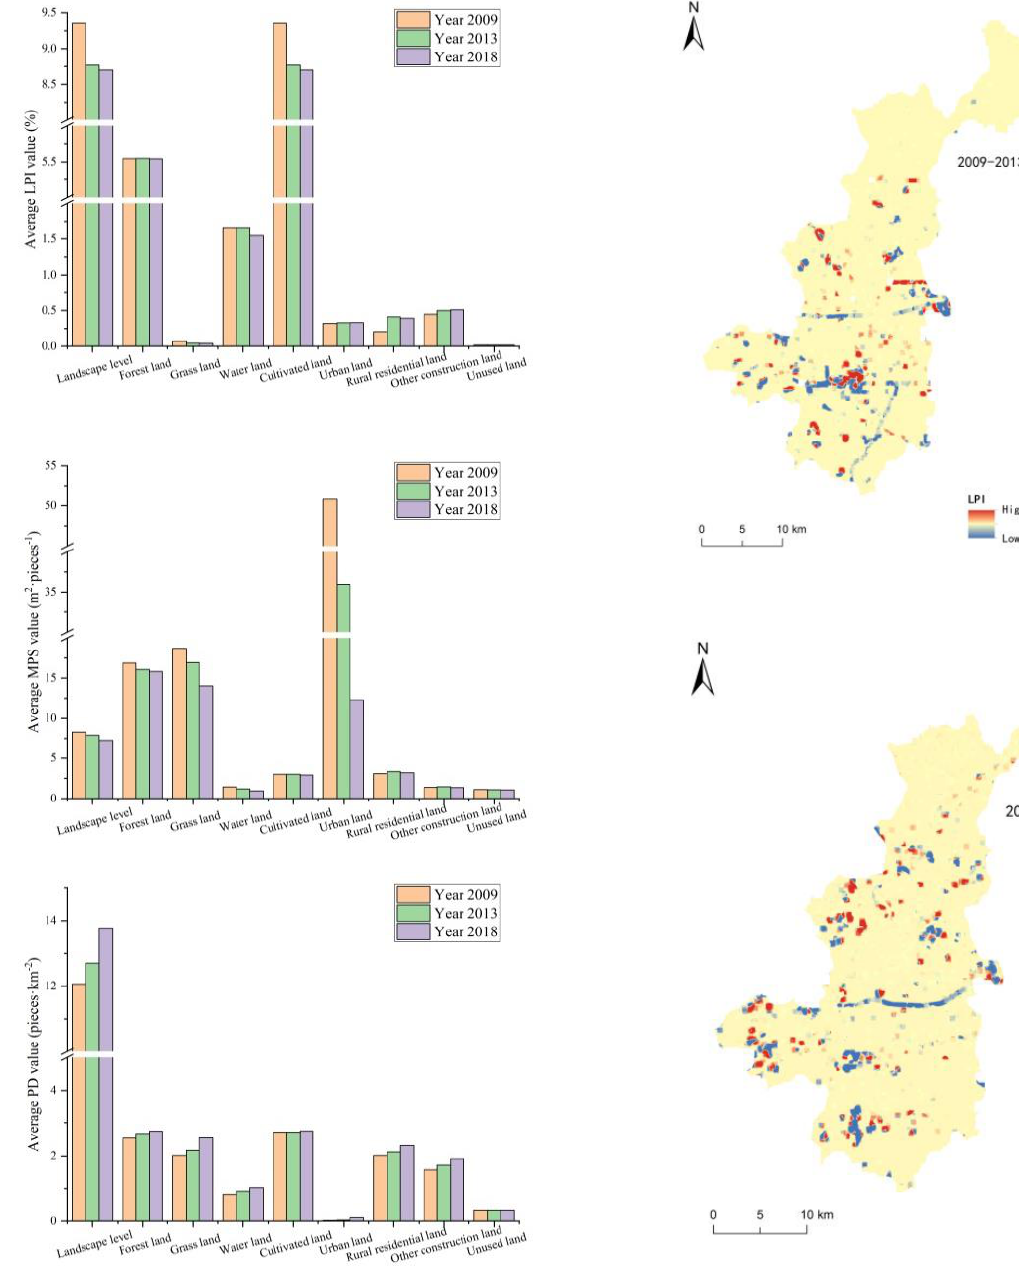
Figure 5. Change in landscape fragmentation in Yujiang District from 2009 to 2018. The spatial changes of the LSI and ED were mainly concentrated in the urban area and around major traffic arteries, which represented the primary area of patch shape change in Yujiang District. However, the LSI exhibited a decreasing trend in the central urban area during 2013–2018 compared with that of the 2009–2013 period (Figure 6), indicating the regularization of landscape